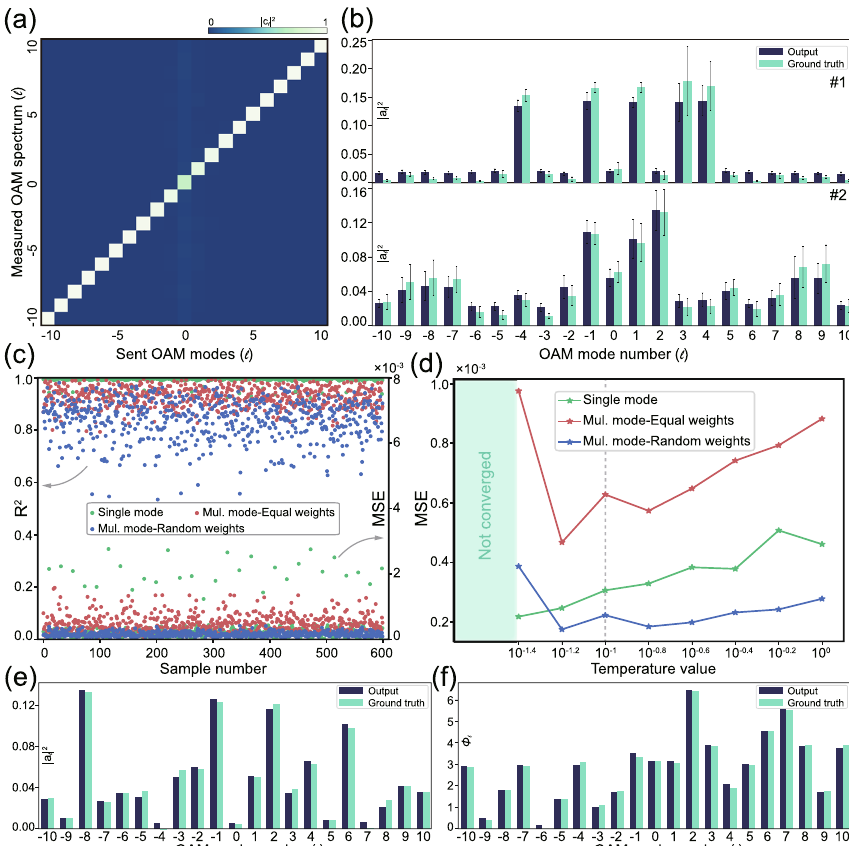
Fig. 3 OAM spectrum results for different structured light. a The results of experimental single modes with TC from − 10 to 10. Horizontal axis denotes different modes under test and longitudinal axis represents measured OAM spectrum. b Two selective results of experimental mul. modes. #1: mul. mode with equal weights. #2: mul. mode with random weights. Results of ( a ) and ( b ) are calculated based on 30 repeated experiments. Errorbar represents standard deviation. c Quantitative metrics to assess OAM spectrum measurement performance on different experimental datasets. Horizontal axis: index of each sample. R 2 : R-squared. MSE: mean squared error. d Model performance comparison on different datasets versus temperature value T . Each MSE value is calculated through the average on the whole experimental dataset. Each T correspondes to a trained model. The opaque cyan region means that the models with corresponding T values are not converged during training. The vertical gray line marks the model in Fig. 2 a – b . e – f OAM complex spectrum on simulated mode. Left: weight. Right: relative